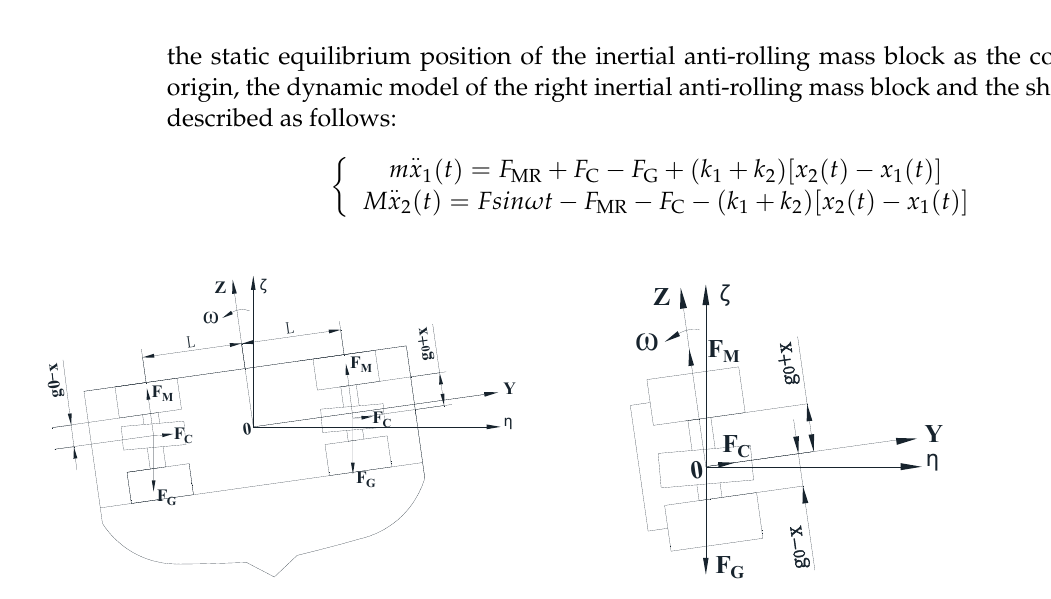
Figure 2. Mechanical analysis diagram of inertia anti-rolling mass block.